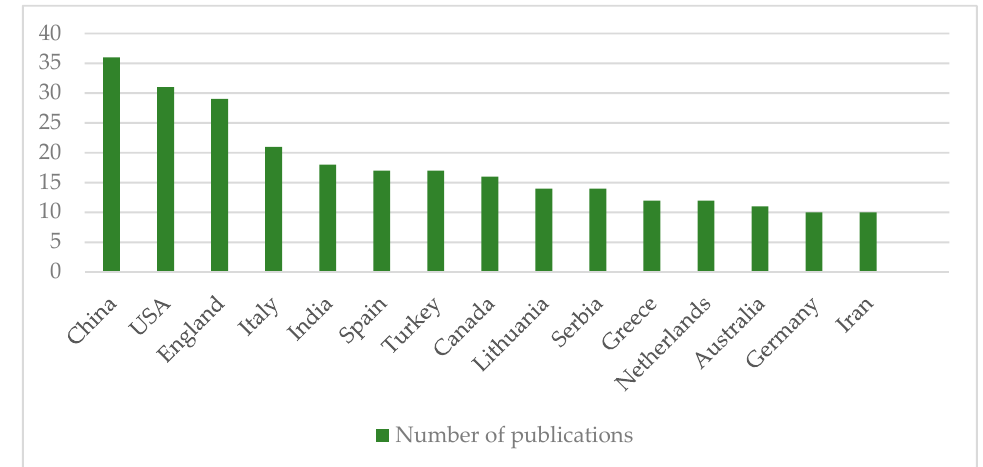
Figure 6. The publications by country on the topics of “multi-criteria decision making” and of “sustainable energy”, 1990–2017. Note: The figure does not represent countries, which have less than 10 publications. Table 3. The publications by journals on the topics of “multi-criteria decision making” and “sustainable energy”, 1990–2017.